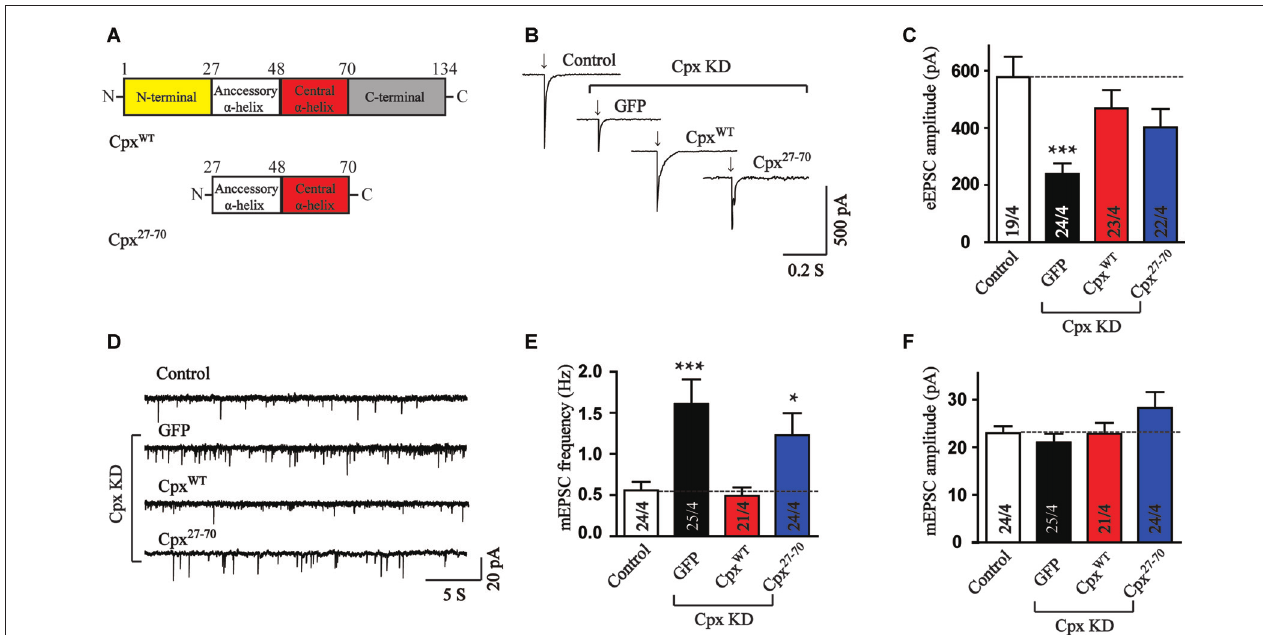
FIGURE 3 | The accessory and central α -helices of complexin selectively activate Ca 2 + triggered vesicle fusion. (A) Domain structures of wild type (Cpx WT ) and the accessory and central α -helices of Cpx (Cpx 27–70 ). (B,C) Representative traces (B) and summary graphs of the amplitude (C) of action-potential evoked AMPAR-mediated EPSCs recorded in cultured cortical neurons that were infected with a control lentivirus (control) or lentiviruses expressing complexin shRNAs (GFP) without or with coexpression of Cpx WT or Cpx 27–70 , respectively. (D–F) Sample trace (D) and summary graphs of the frequency (E) and amplitude (F) of mEPSCs monitored in neurons as described for (B) . Data shown in summary graphs are means ± SEM; numbers of cells/independent cultures analyzed are listed in the bars. Statistical assessments were performed by the Student’s t -test comparing each condition to the indicated control experiment ( ∗ p < 0.05, ∗∗∗ p <